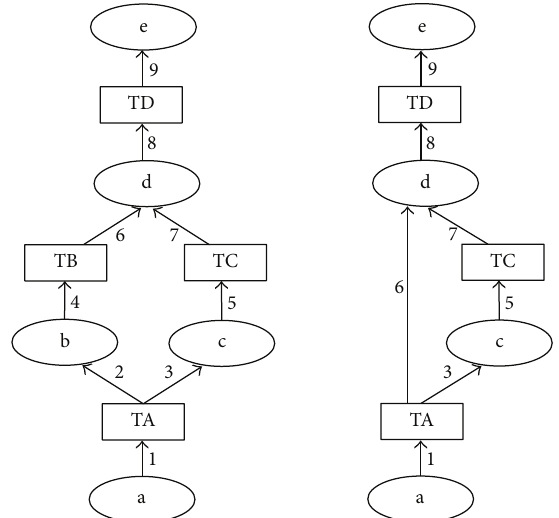
Figure 4: The original model and the reduced model.